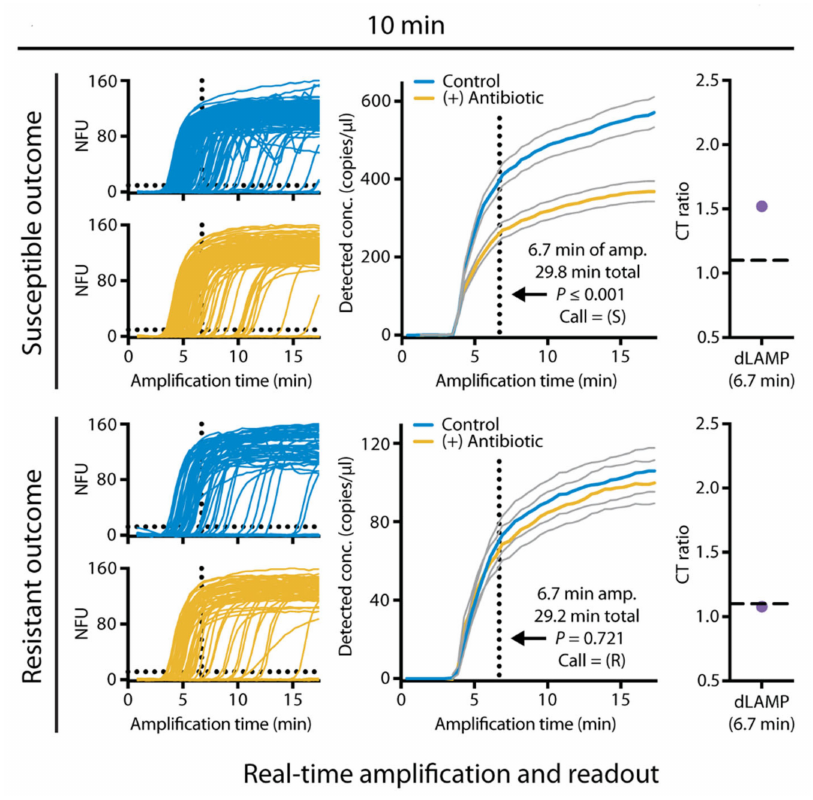
Figure 1. Sample-to-answer antimicrobial susceptibility testing (AST) in less than 30 min for Es- cherichia coli in urine using digital loop-mediated isothermal amplification (dLAMP). Data for one resistant and one susceptible sample are shown. dLAMP was monitored in real-time, and a sus- ceptibility call was determined after 6.7 min of amplification. Gray lines represent 95% confidence intervals. Reprinted from reference [31] with